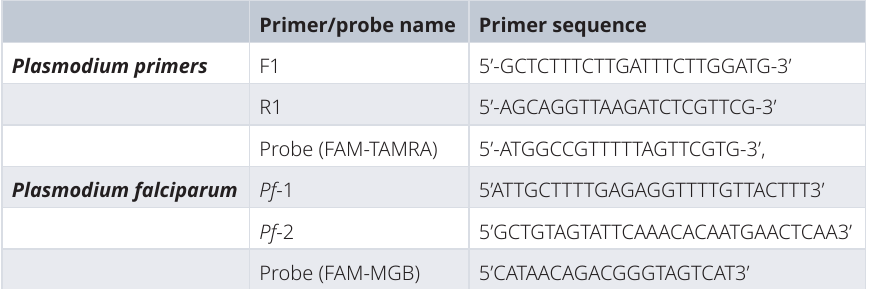
Table 1. Primers and probes used to diagnose Plasmodium parasite and detect Plasmodium falciparum species in real time PCR. These are primers and probes were published in previous work by Kamau et al.